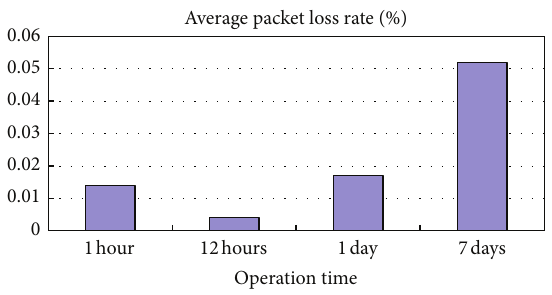
Figure 12: Average packet loss rate with varied operation